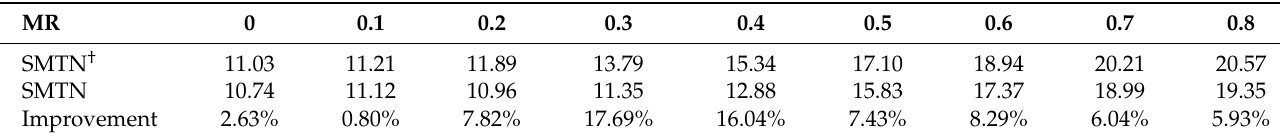
Table 3. The performance comparison of SMTN † and SMTN on FD003 using RMSE under differ- ent